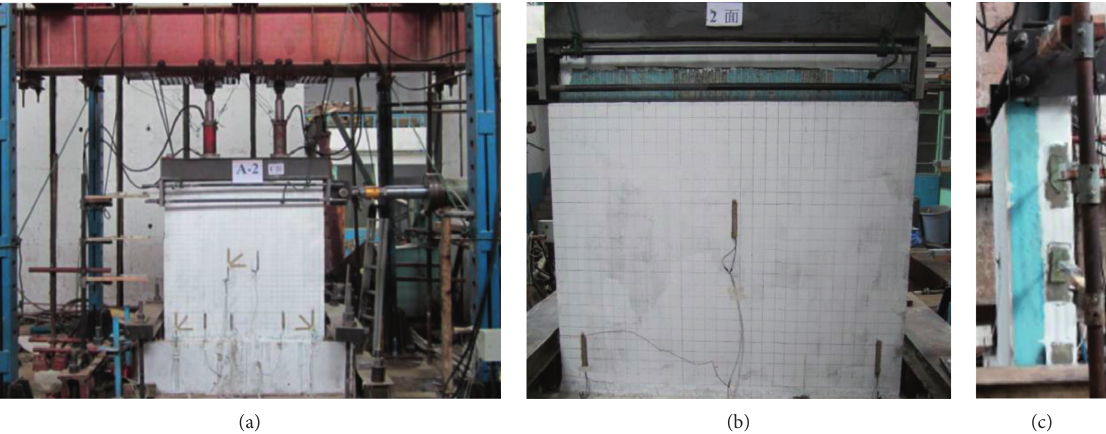
Figure 4: Experimental apparatus. (a) Positive. (b) Back. (c)